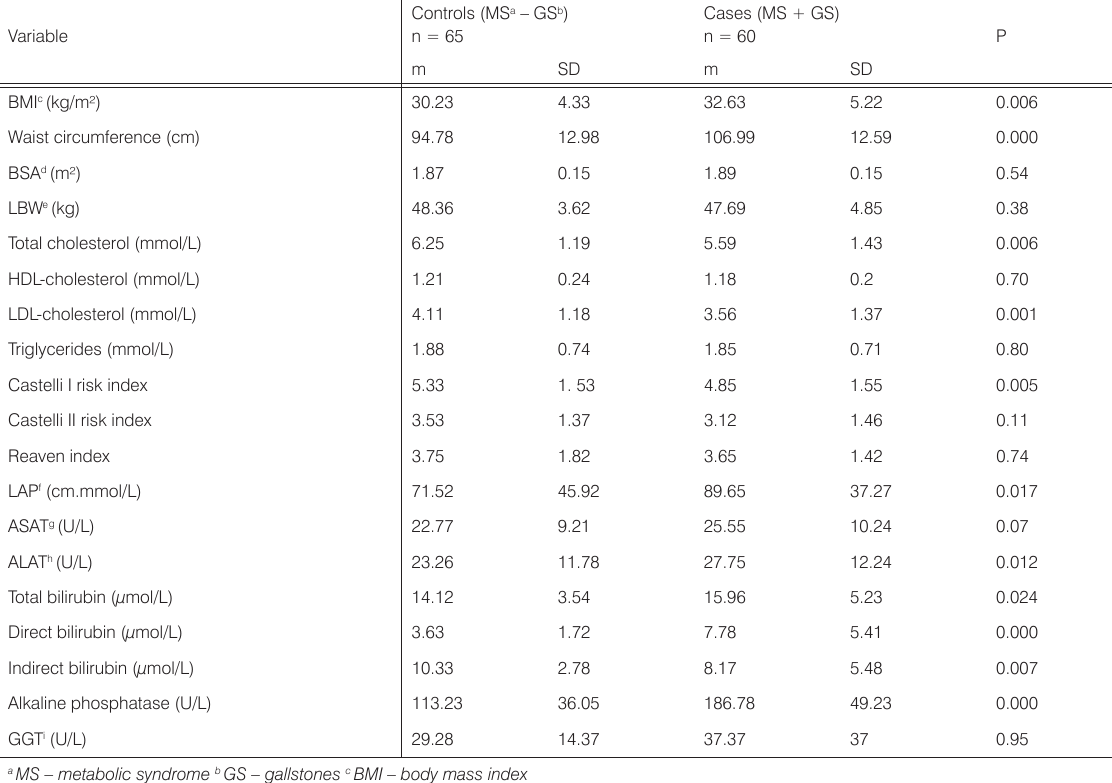
Table 1. Mean differences of continuous variables between cases and controls Variable